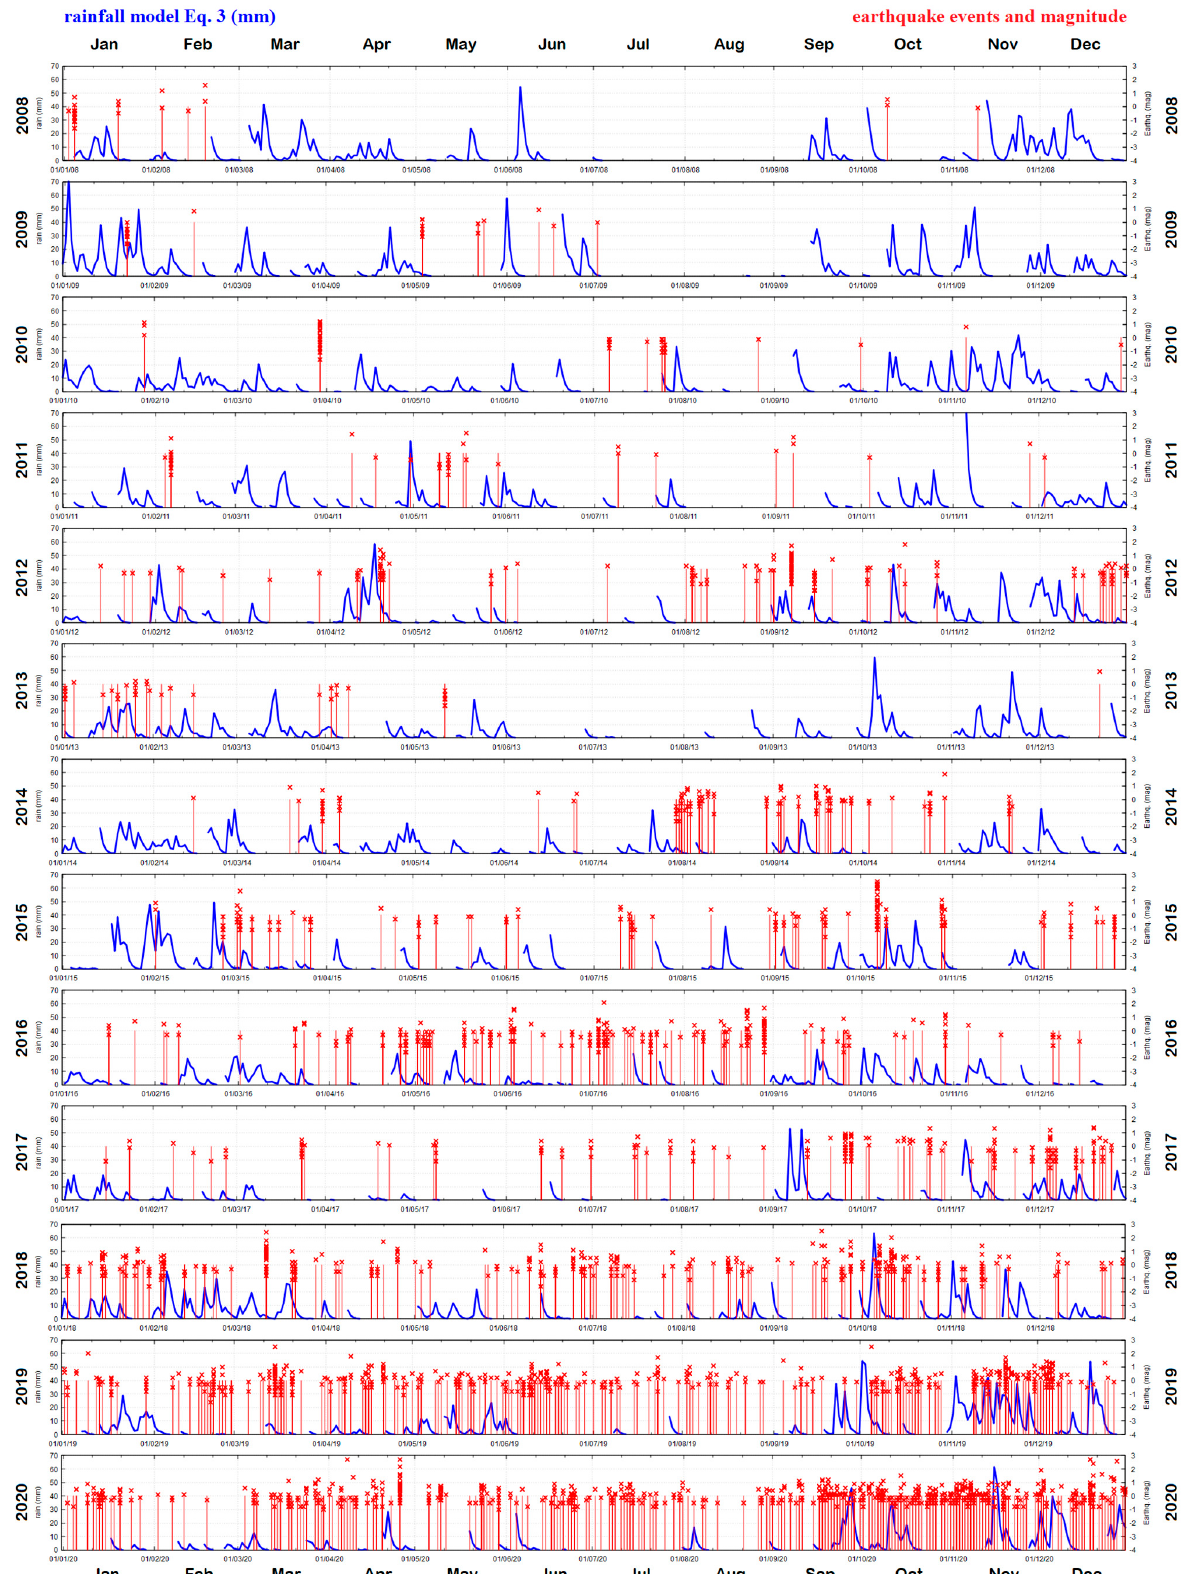
Figure 3. Scenario #2: R = 0.1 mm and τ = 1 day. Comparison between the empirical water stress-function (Equation (3)) estimated with the rainfall record of the Meteorological Observatory at San Marcellino in Naples (blue) and the seismic events at the Phlegraean Fields from 2008 to 2020 (red). Each panel covers one year. See Table 2.